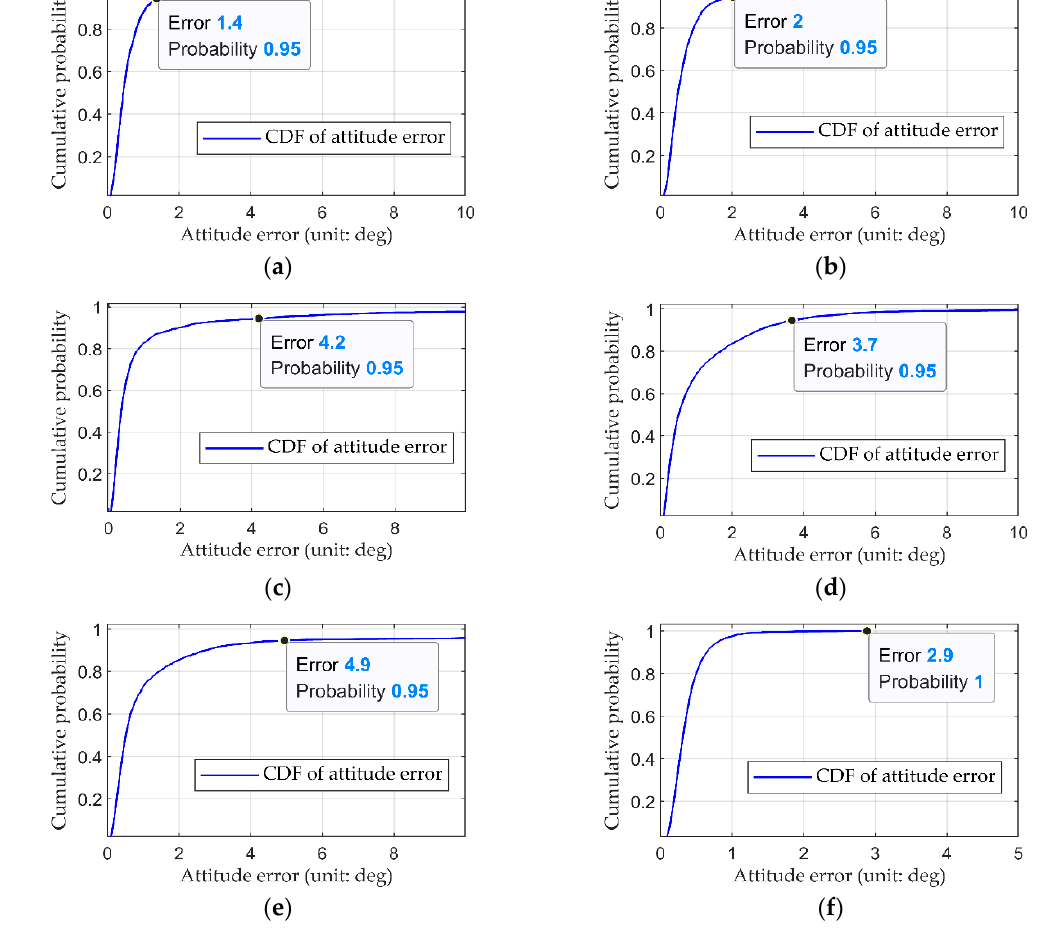
Figure 11. Cumulative distribution function (CDF) of attitude error in the ( a ) freibuig1_plant, ( b ) freiburg1_room, line of each sub-figure represents the CDF curve. The vertical coordinate represents the cumulative probability of attitude error.